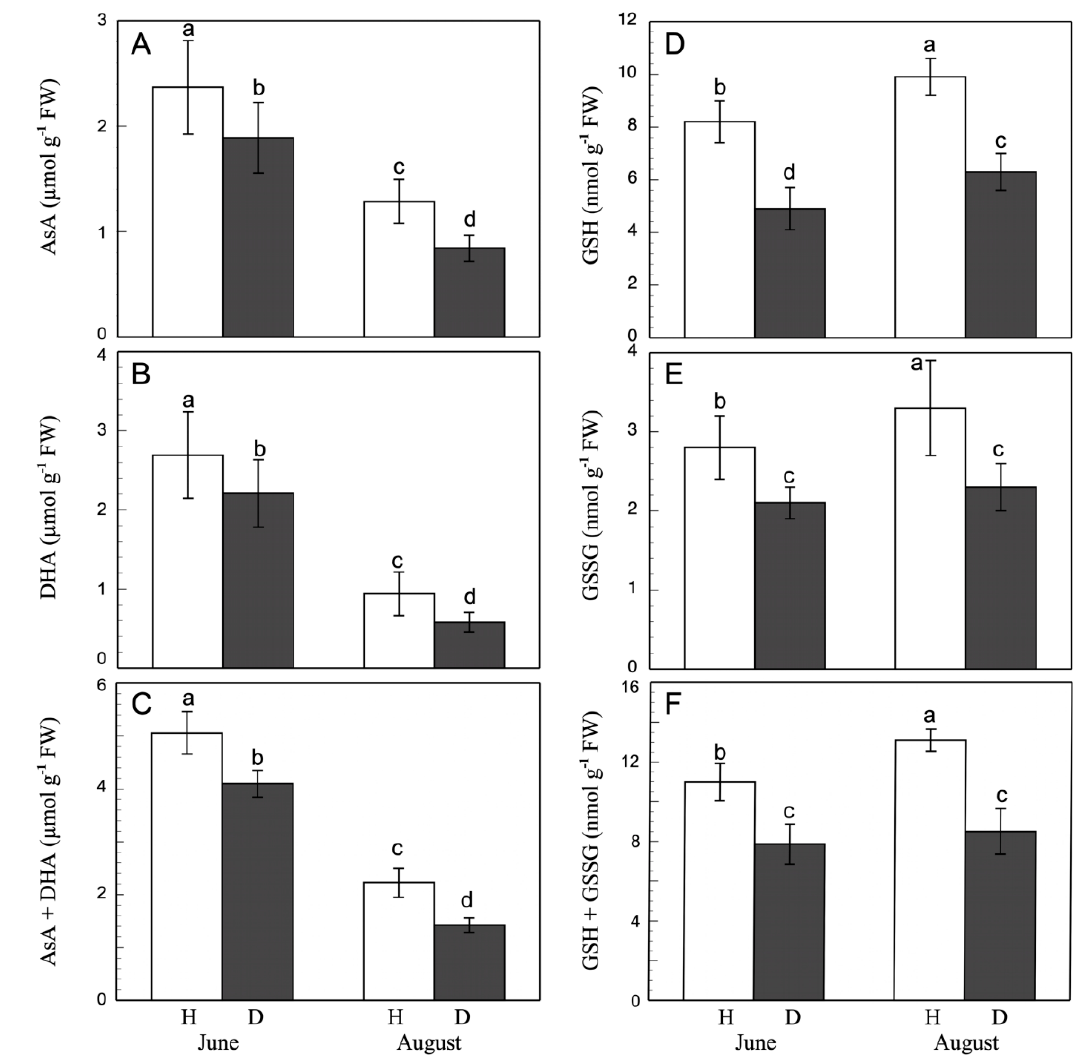
Figure 3. AsA ( A ), DHA ( B ), ascorbate pool ( C ), GSH ( D ), GSSG ( E ), and glutathione pool ( F ) in grapevine healthy (H) and esca-diseased (D) leaves from June and August. The data are means ± SD from 10 independent experiments, each carried out in triplicate (different letters indicate significant differences at p < 0.05, Mann–Whitney U test).